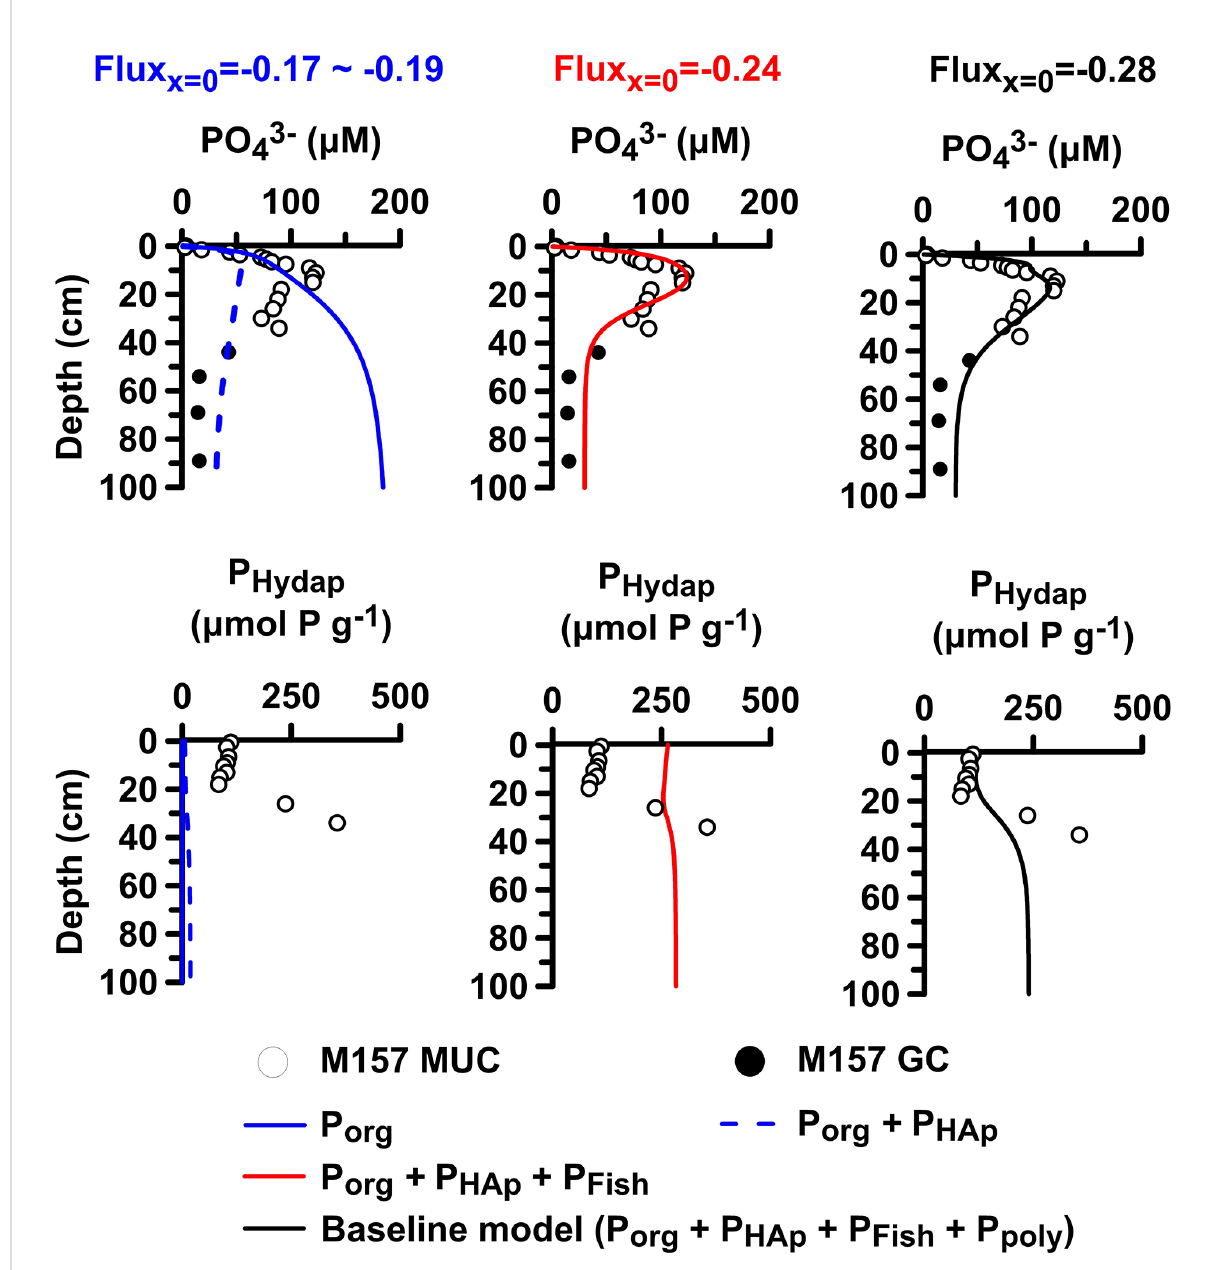
FIGURE 8 Model sensitivity analysis of porewater PO 3 − 4 and P Hydap at St. 41 for increasing model complexity (see text). Baseline model values are shown as black curves and measured data as symbols. P Fe is included in the plots, but since it makes a negligible contribution to total P, the corresponding data are not shown explicitly. The changing PO 3 − 4 benthic at each step is shown above each